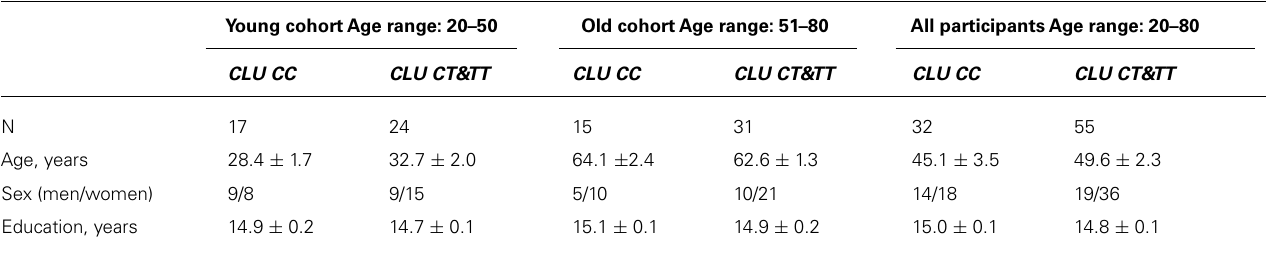
Table 1 | Demographic characteristics of